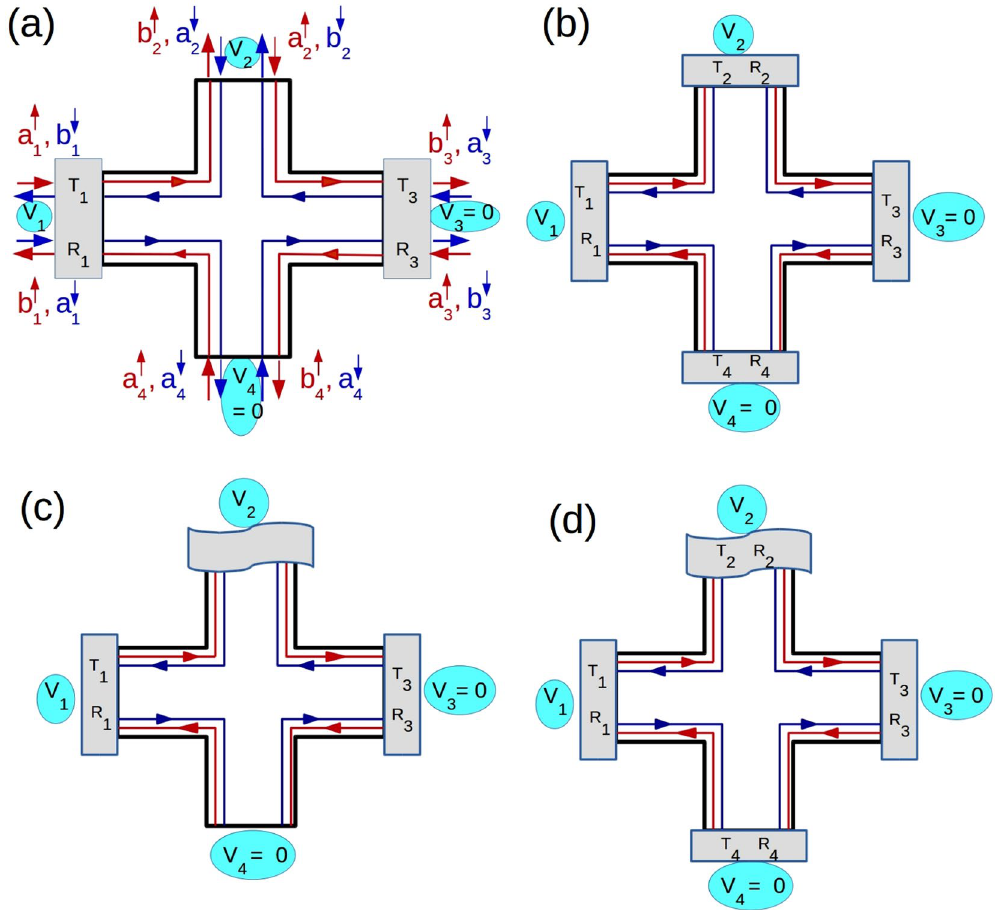
Figure 5. Four terminal Quantum Spin Hall bar showing QSH edge modes. These edge modes differ from their QH counterparts since these are spin polarized and helical, probes 3 and 4 are detectors kept at zero potential. (a) Two disordered probes and ( b ) All probes disordered. = − R T 1 represents the reflection probability of i i edge modes from and into contact i with the strength of disorder in contact i ranging from < < R 0 1 . (c) Two i disordered contacts with inelastic scattering. ( d ) All disordered probes with inelastic scattering, (probe 2 is a voltage probe in both (c) and (d) with I 2 = 0).In ( a ) the incoming and outgoing waves into the probes are explicitly shown, these are not repeated in ( b – d ) to avoid